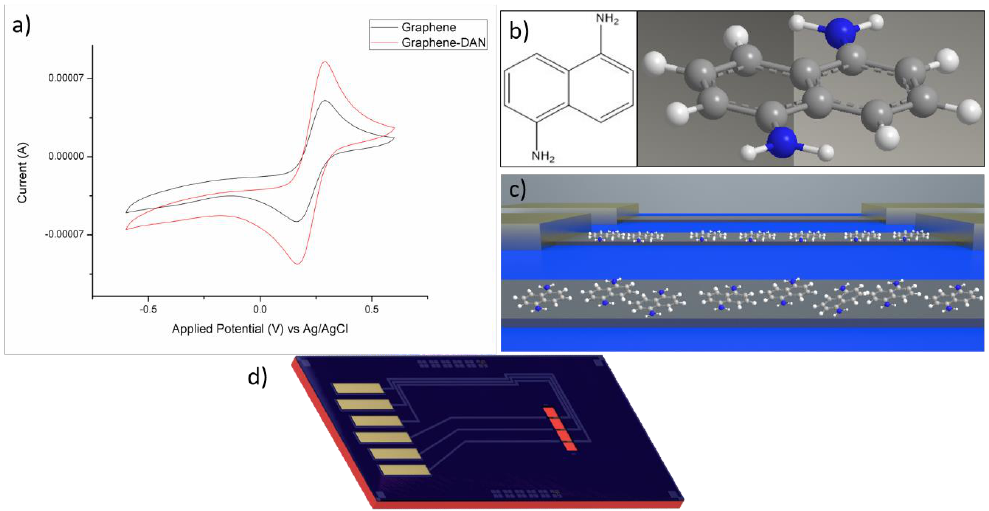
Figure 1. ( a ) Cyclic voltammograms (CVs) of a graphene screen-printed electrode before and after surface modification with 1,5-diaminonaphthalene (DAN): unmodified graphene (black) and DAN modified (red). CVs were carried out in [Fe(CN) 6 ] − 3 / [Fe(CN) 6 ] − 4 in 1 × PBS (pH 7.4), at a scan rate of 50 mV / s and a potential window of − 0.6–0.6 V; ( b ) structure of DAN; ( c ) illustration of DAN on graphene resistor devices; ( d ) Schematic of graphene resistor